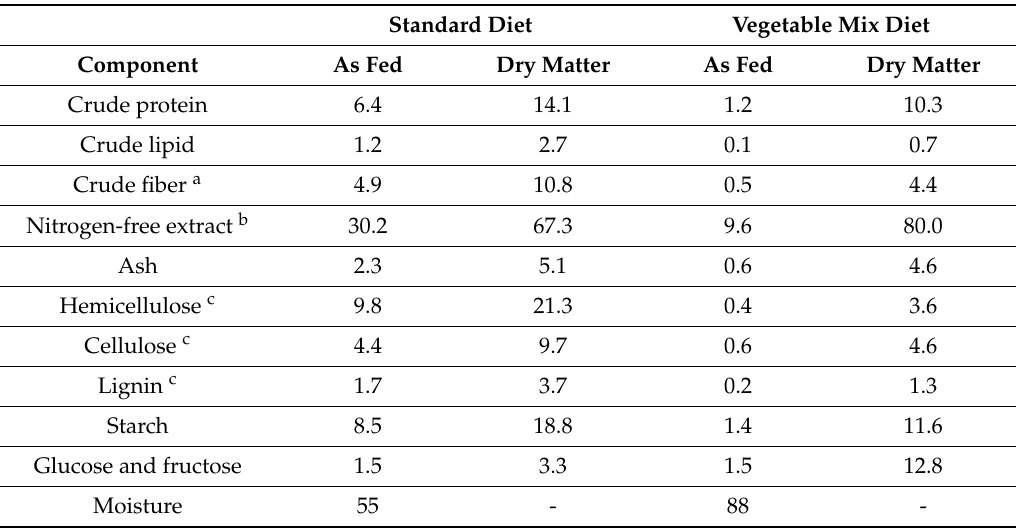
Table 1. Chemical composition and moisture content of the two experimental diets. Values are expressed as g per 100 g of